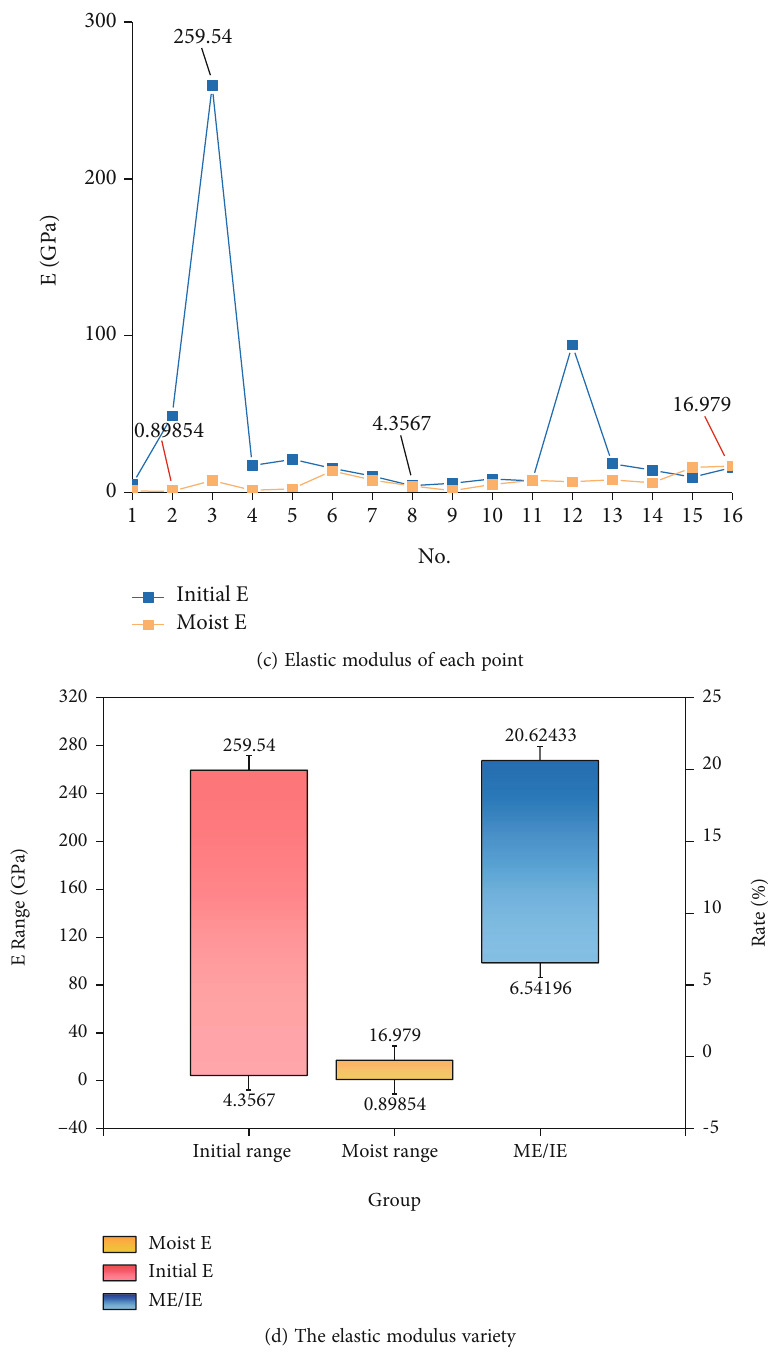
Figure 9: The comparison of hardness and elastic modulus between the dry and the